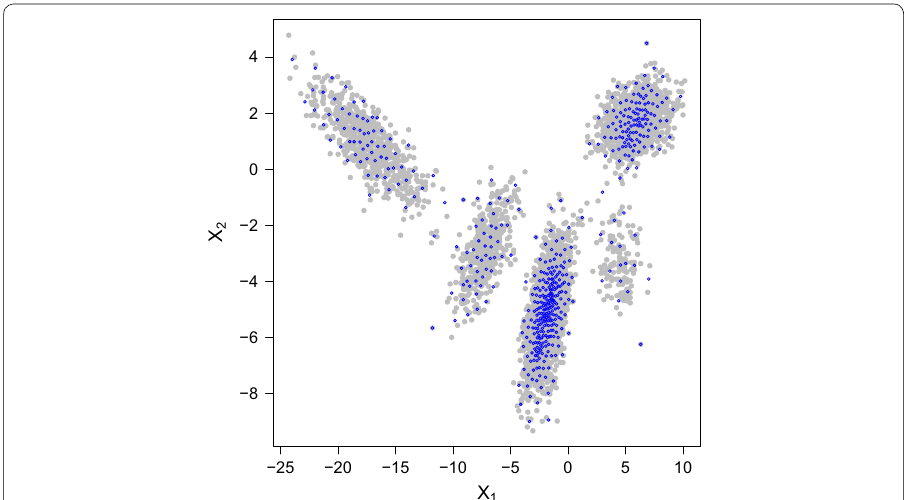
Fig. 1 Quantization via k -means. A dataset of 5000 observations (plotted in solid gray points) is drawn from a Gaussian mixture of 5 components and reduced to 500 quantized values (plotted in blue